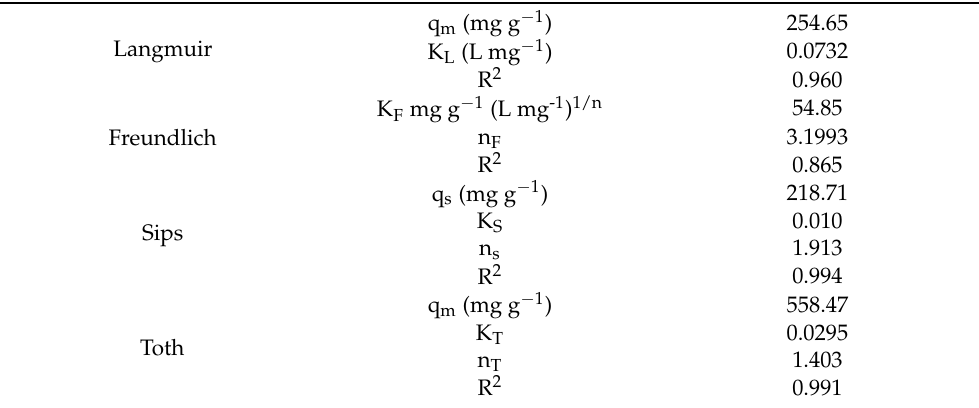
Figure 9. Adsorption data for RF/TiO 2 onto MB dye corresponding fits to Langmuir, Freundlich, Sips, and Toth equation. Table 2. Isotherm parameters obtained by fitting MB adsorption data for RF/TiO 2 to the Langmuir, Freundlich, Sips, and Toth equations .